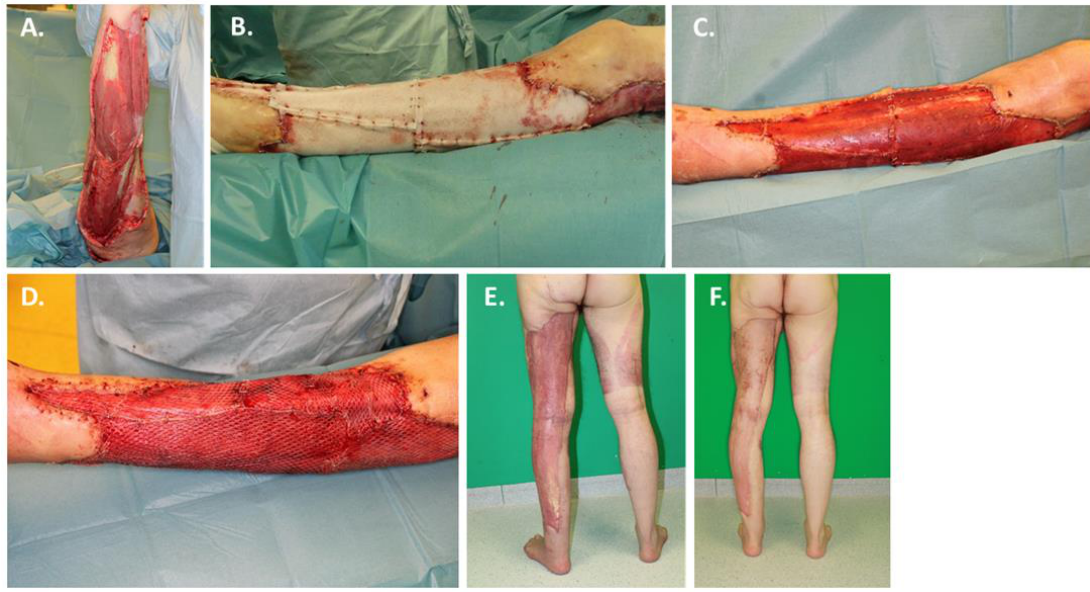
Figure 3. A case of necrotizing fasciitis treated with BTM. A 56-year-old male was admitted with necrotizing fasciitis affecting semicircular the left lower leg and the left thigh dorsal to gluteal: ( A ) Wound situation after multiple surgical debridement for local remediation; ( B ) At the time of implantation of BTM Klebsiella pneumoniae could be detected microbiologically; ( C ) Successful integration and delamination of BTM after 20 days; ( D ) Definitive defect coverage with autologous split-thickness skin grafting; ( E ) 3-month follow-up; ( F ) 6-month follow-up.